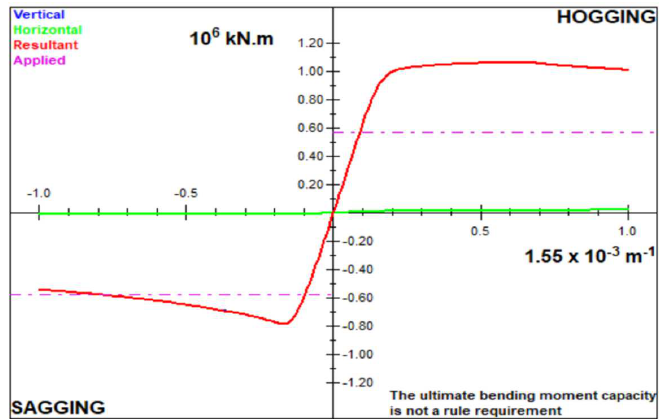
Figure 2. Bending moment-curvature relationship, SHDMF = 1, vertical (blue) is the bending moment axis, horizontal (green) is the curvature axis, resultant (red) is the hull girder strength and applied (pink) is the bending moment the hull girder needs to support.